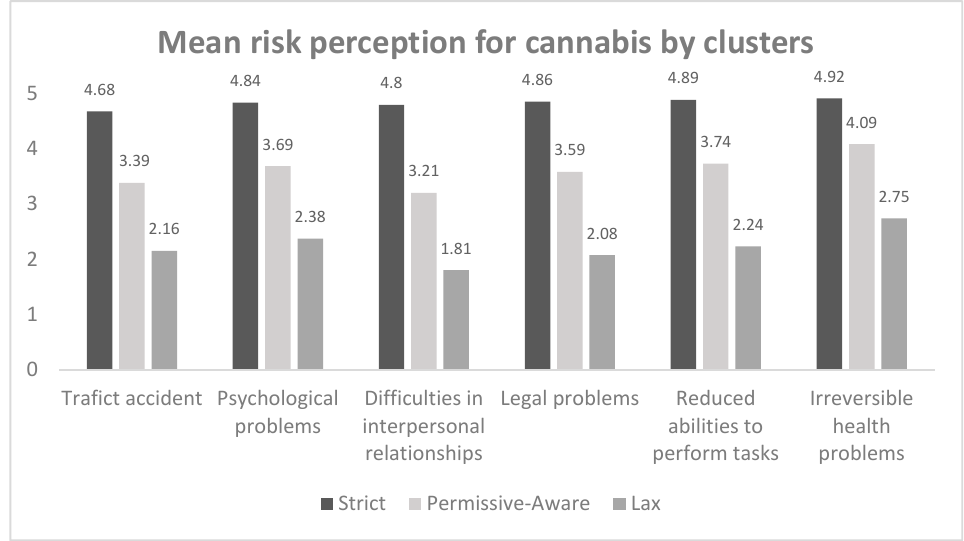
Figure 1. Mean risk perception on the Likert scale (1 to 5) for cannabis in six dimensions ( x -axis) and for the three perceptual style groups produced by the cluster analysis. In the ANOVA, all differences were significant ( p < 0.001) throughout the six dimensions.